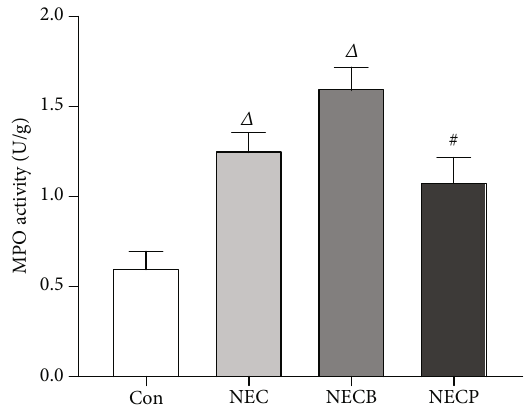
Figure 4: Inhibition of A R by PSB1115 downregulated MPO 2B activity in NEC rats. MPO activities were determined in all animals at the end of experiments. Animals in the NECP group showed signi fi cantly lower MPO activity as compared with those in the NEC and NECB groups. NEC: necrotizing enterocolitis; NECB: necrotizing enterocolitis+BAY60-6583 treatment; NECP: necrotizing enterocolitis+PSB1115 treatment. Δ p < 0 : 001 vs. all other groups; # p < 0 : 001 vs. the Con